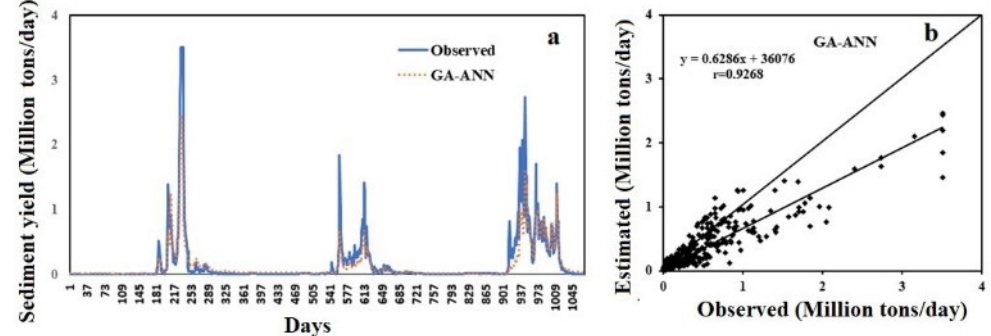
Figure 6. ( a ) Hydrograph and ( b ) scatter plot based on test data between the predicted GA-ANN SSY and observed SSY.